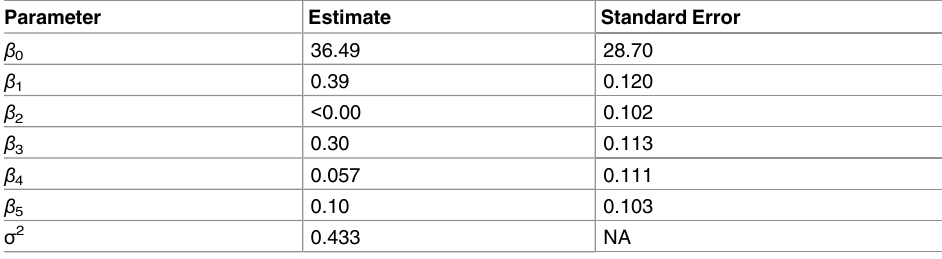
Table 5. Results of negative binomial time series regression INARCH model for daily time series of AI-related Twitter activity (Log-likelihood: -920.29, AIC: 1854.58, log score: 60.59, ranked probability score: 109.36)